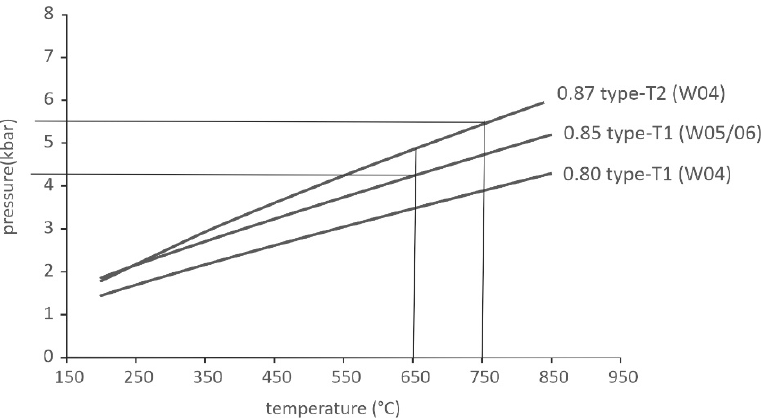
Figure 8. Estimated pressures for tourmaline crystallization calculated from Type-T1 and T2 density isochores of samples W04/05/06. Numbers correspond to the highest densities. The temperature range of 650–750 °C is based after Konzett et al. [9].